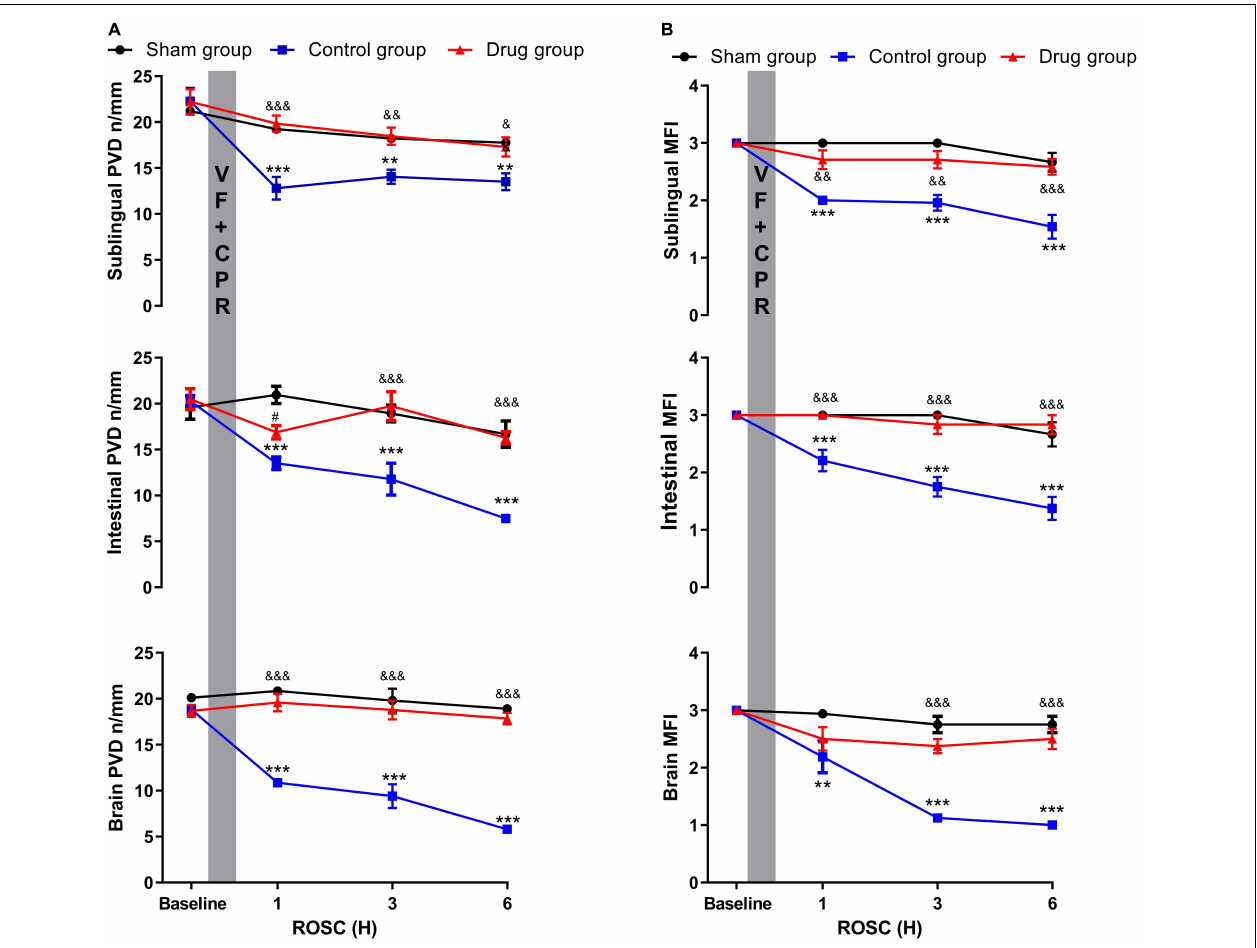
FIGURE 3 | MP effects on post-resuscitation microcirculation. (A) Perfused vessel density, (B) microcirculatory flow index. PVD, perfused vessel density; MFI, microcirculatory flow index; VF, ventricular fibrillation; CPR, cardiopulmonary resuscitation. Data were presented as mean ± SD ( n = 6 in each group). ** p < 0.01, *** p < 0.001 control vs. sham group; & p < 0.05, && p < 0.01, &&& p < 0.001, drug vs. control group; # p < 0.05, drug vs. sham